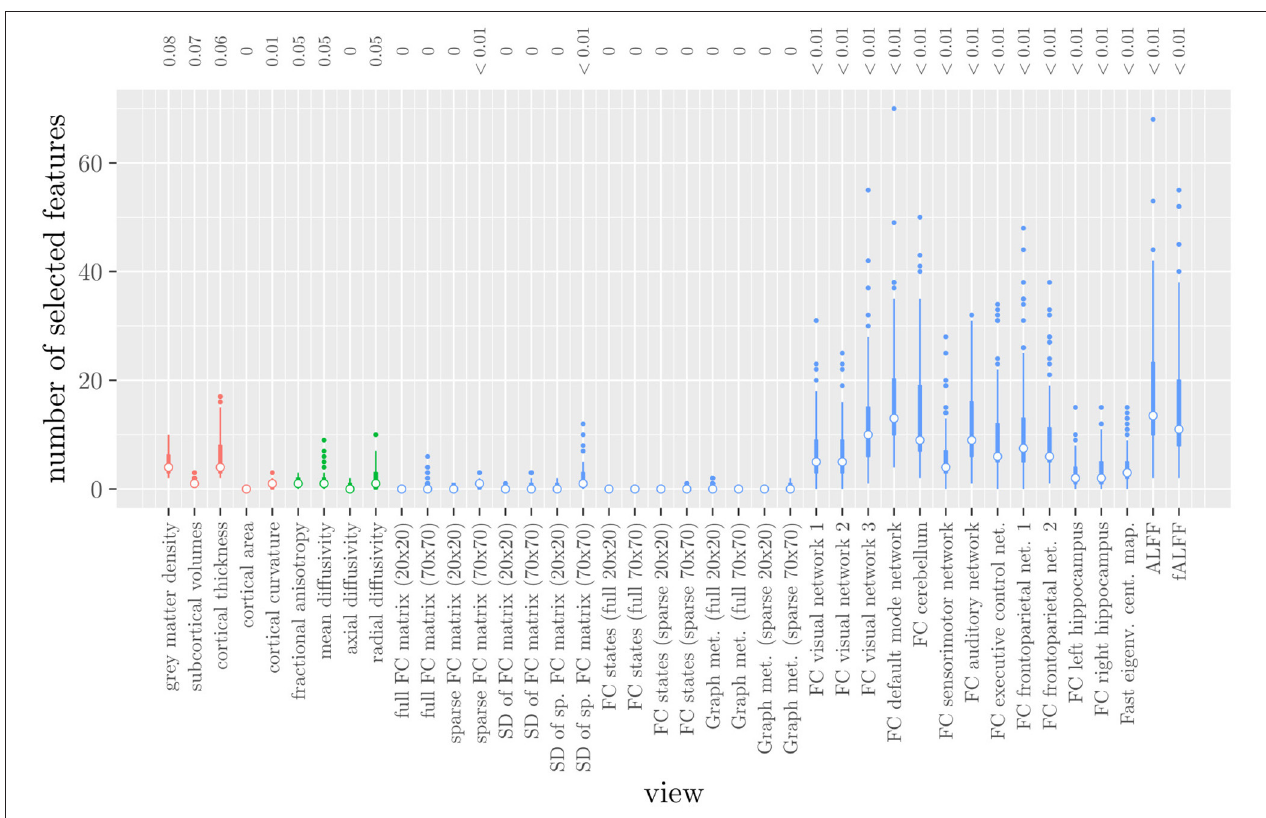
FIGURE 1 | Boxplots of the number of selected features for each MRI measure resulting from the elastic net regression, colored by scan type (red = structural MRI, green = diffusion MRI, blue = resting state fMRI). The numbers at the top of the graph denote the median proportion of nonzero